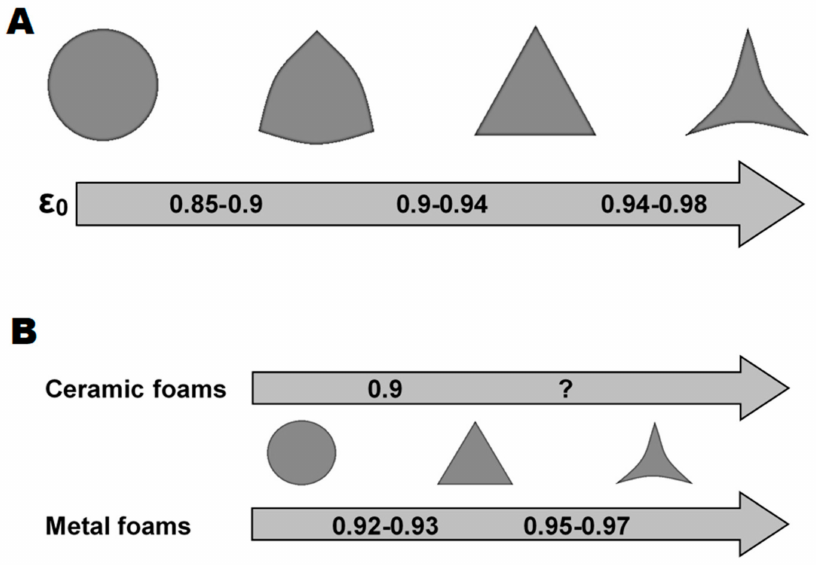
Figure 7. Dependence of strut shape on porosity: ( A )—according to Bhattacharya [21]; ( B )—according to Inayat